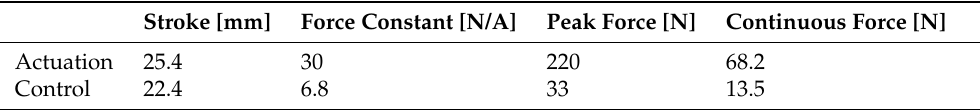
Table 1. VCA specification. “Actuation” refers to the vibration actuation VCA mentioned in Figure 2, while “Control” refers to the vibration control VCA. Stroke [mm] Force Constant [N/A] Peak Force